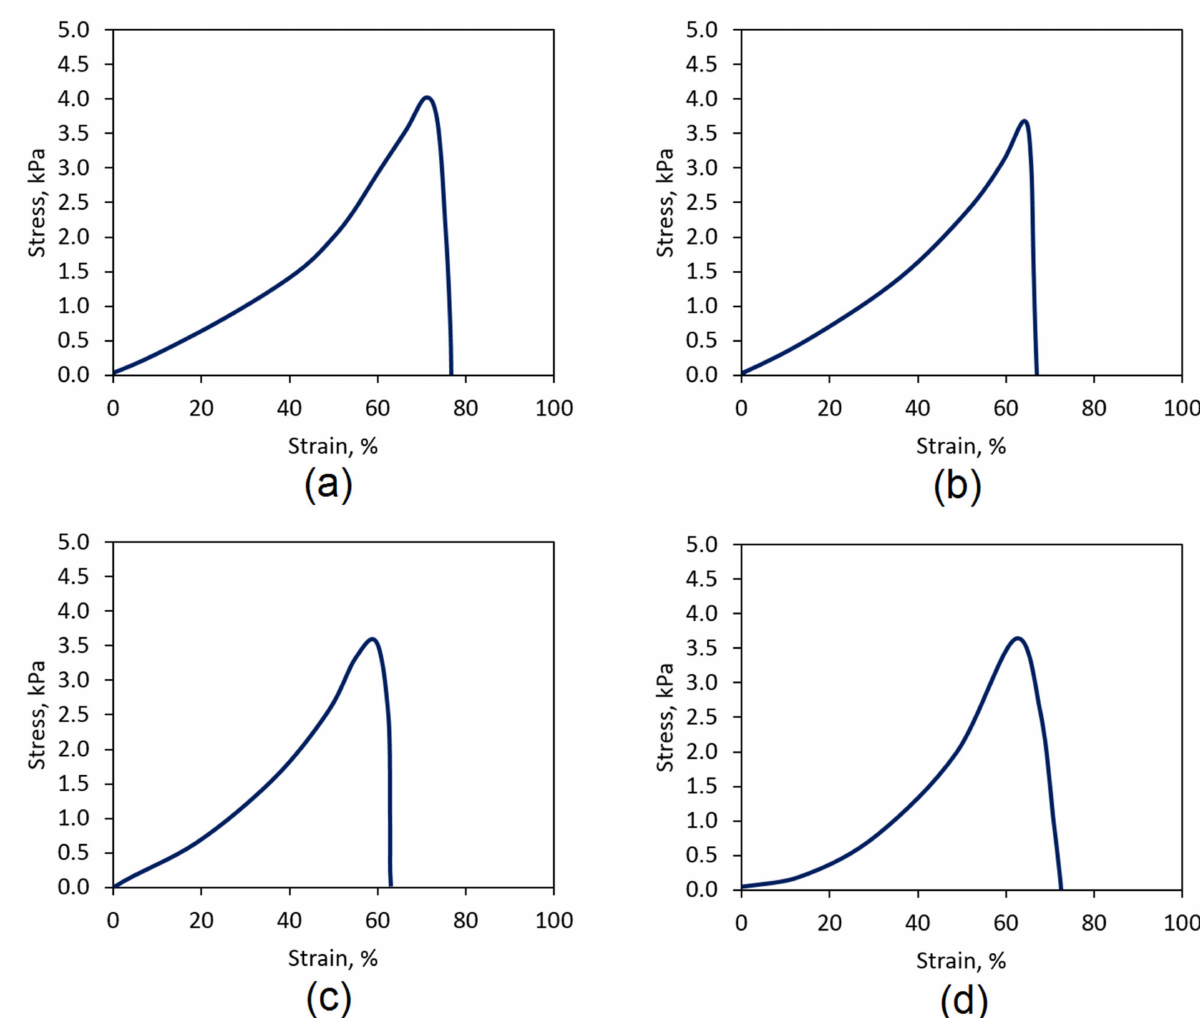
Figure 17. Mechanical durability of the samples: ( a ) Gel-1; ( b ) Gel-2; ( c ) Gel-3; ( d )